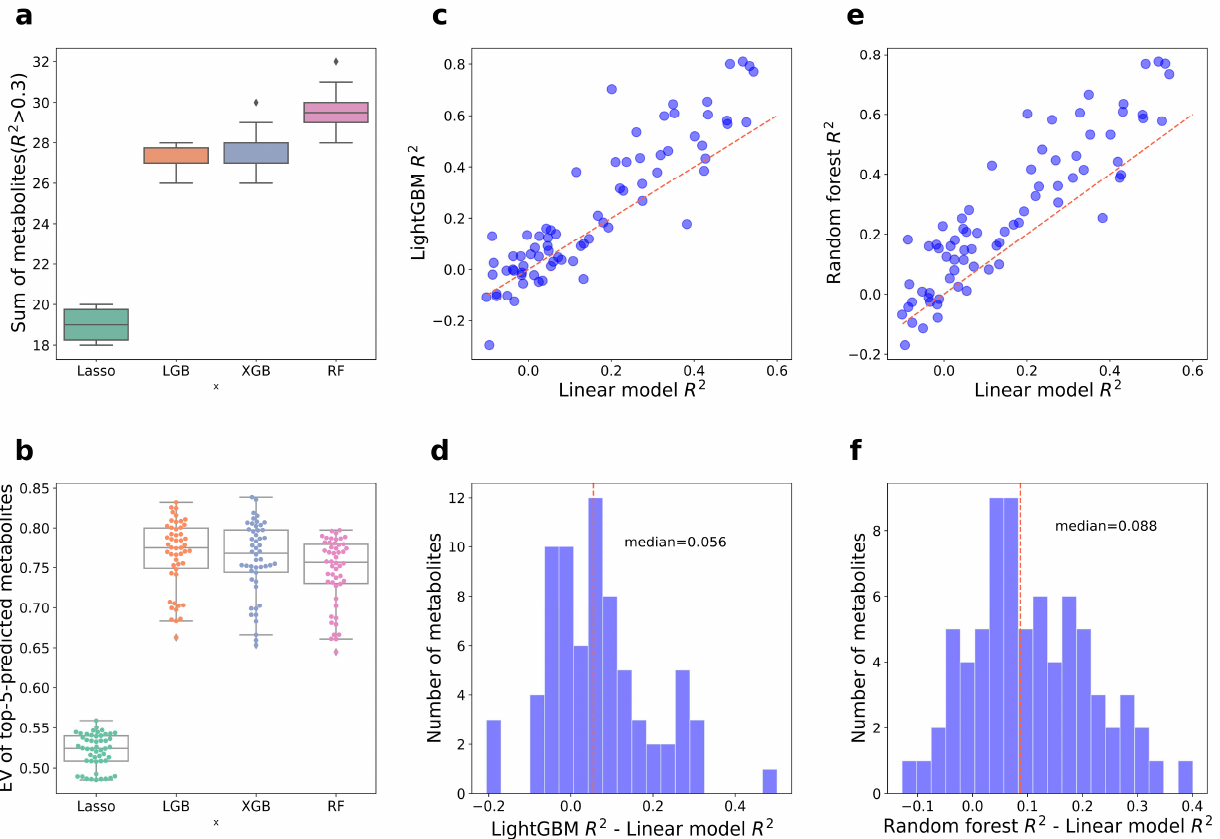
Figure 3. Model selection. ( a ) Sum of metabolites ( R 2 > 0.3) for different models. ( b ) Box and swarm plot of explained variance of top five predicted metabolites in 10 runs. ( c , e ) Dot plots of the explained variance of the metabolite groups from different machine learning models. ( d , f ) Distribution of difference value between different models.